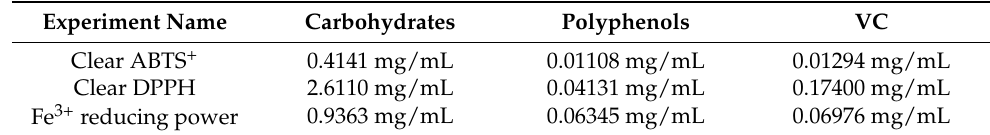
Table 5. In vitro antioxidant experimental IC 50